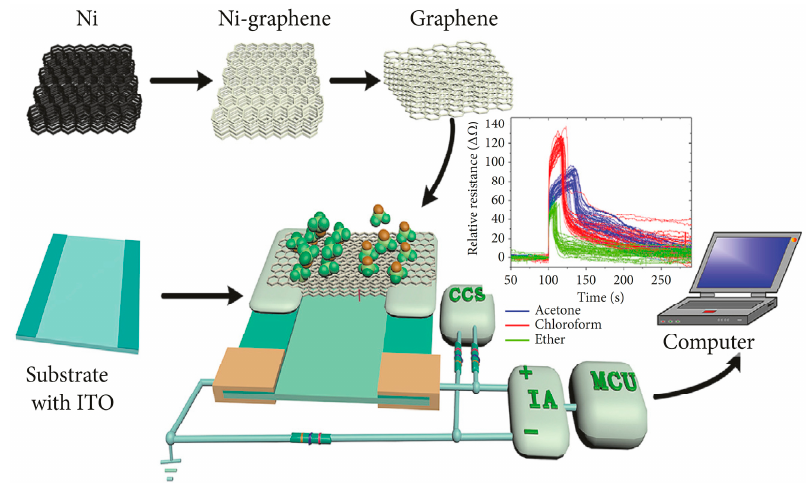
Figure 8. The fabrication process of 3D graphene foam and the electrical resistance time domain detection system (CCS: constant current source; IA: instrument amplifier; MCU: micro control unit). Reprinted with permission from ref. [125].